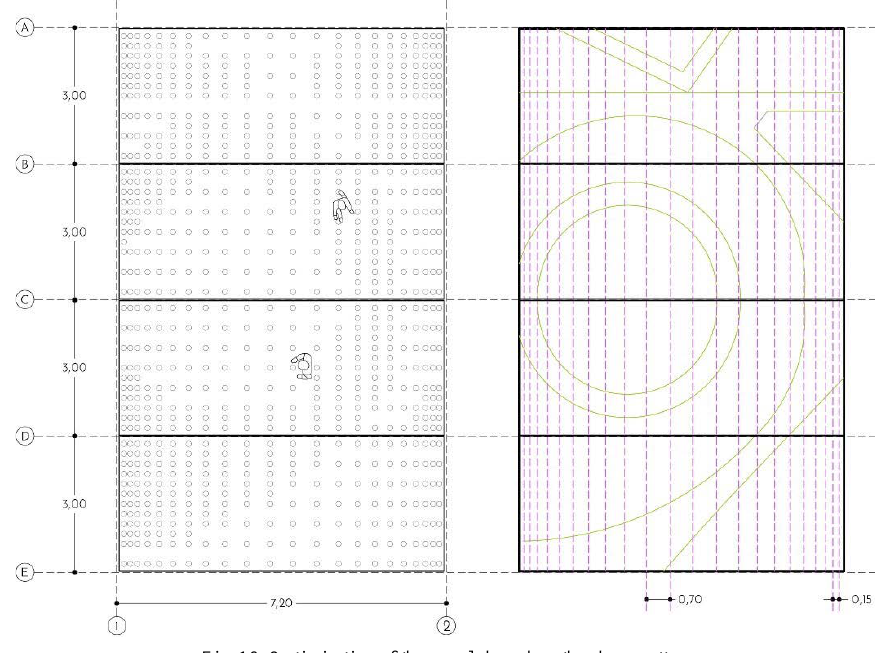
Fig. 16: Optimisation of the panels based on the shear pattern